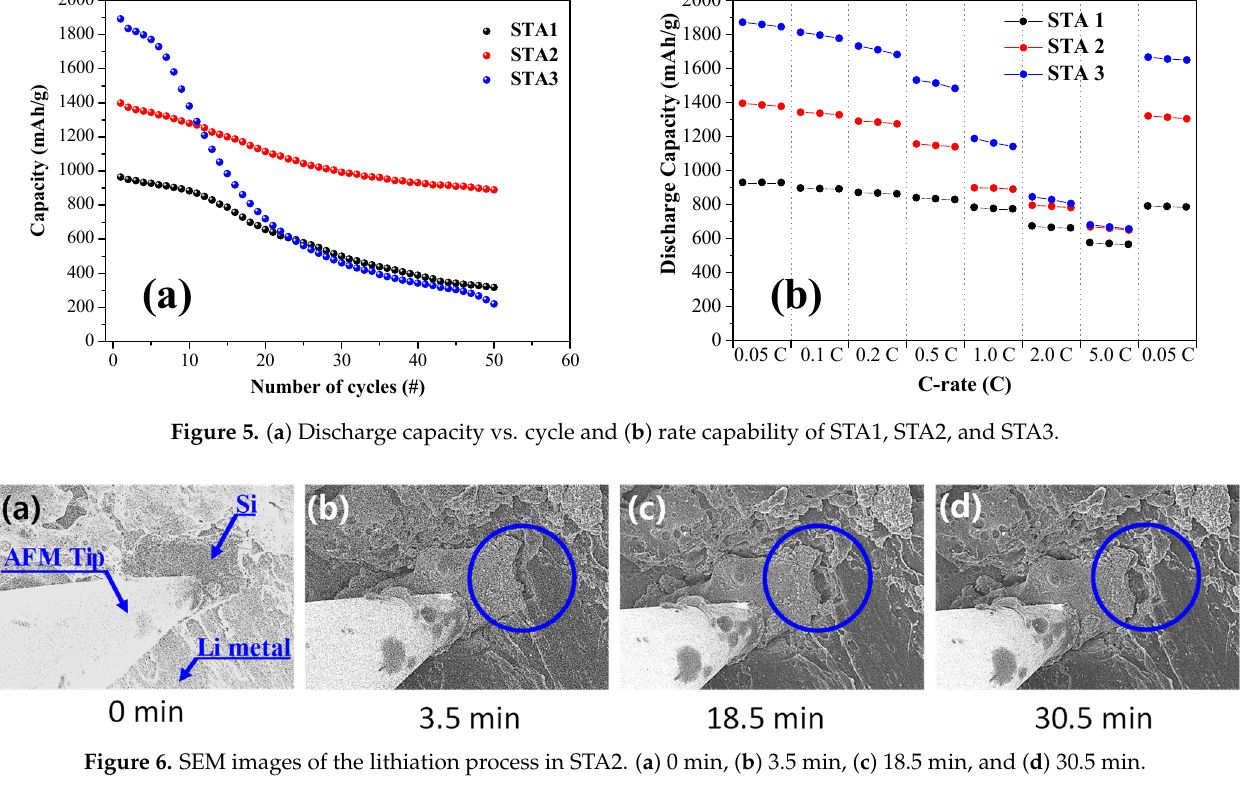
Figure 6. SEM images of the lithiation process in STA2. ( a ) 0 min, ( b ) 3.5 min, ( c ) 18.5 min, and ( d ) 30.5 min.